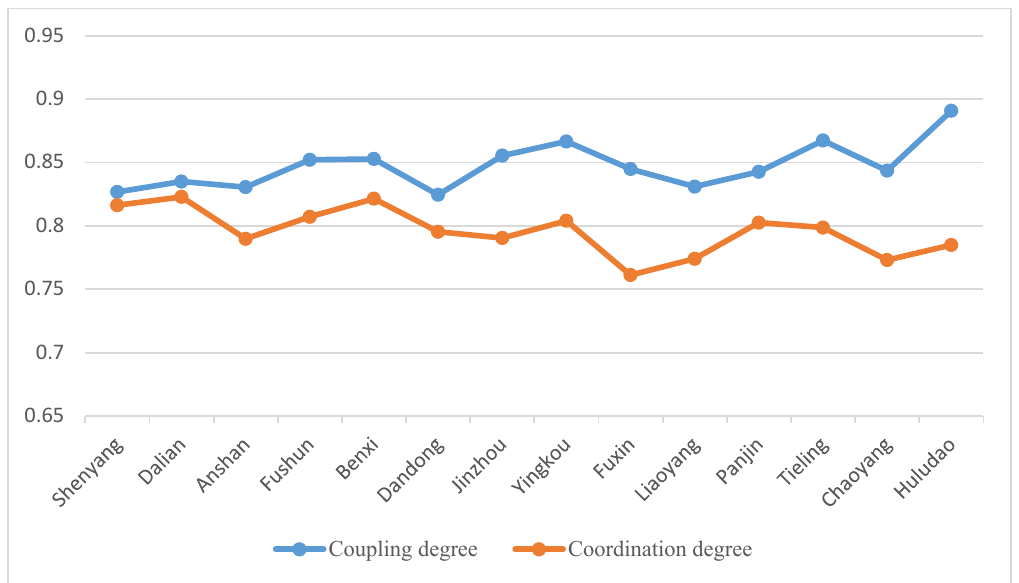
Figure 6. Line chart of coupling and coordination degrees of LCCC system in Liaoning Province.